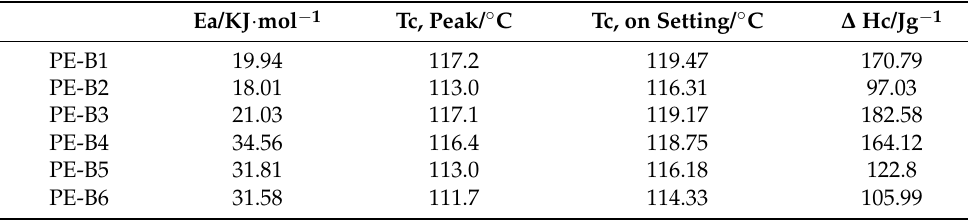
Table 3. Rheological and crystallization properties of polyethylene